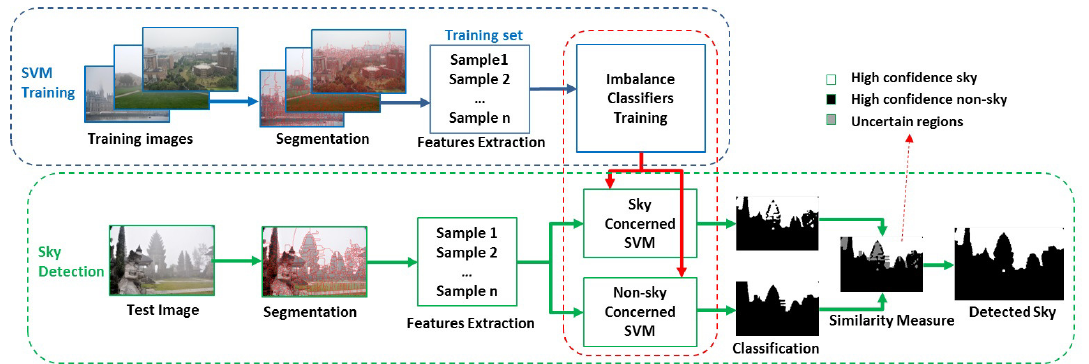
Figure 2. Illustration of the proposed sky detection